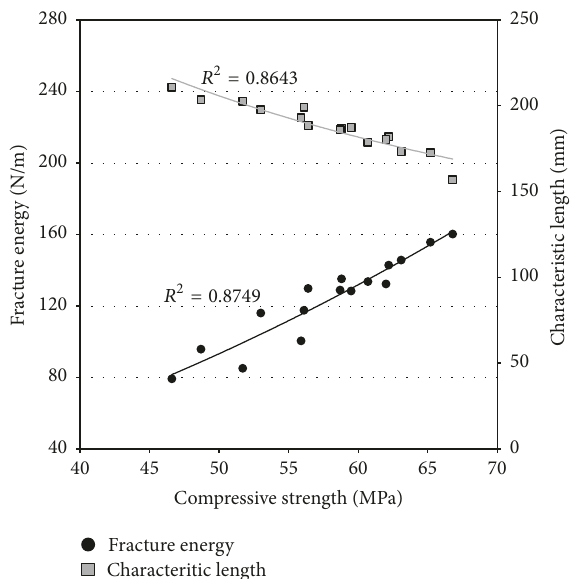
Figure 11: Fracture energy and characteristic length of SCCs versus compressive strength.